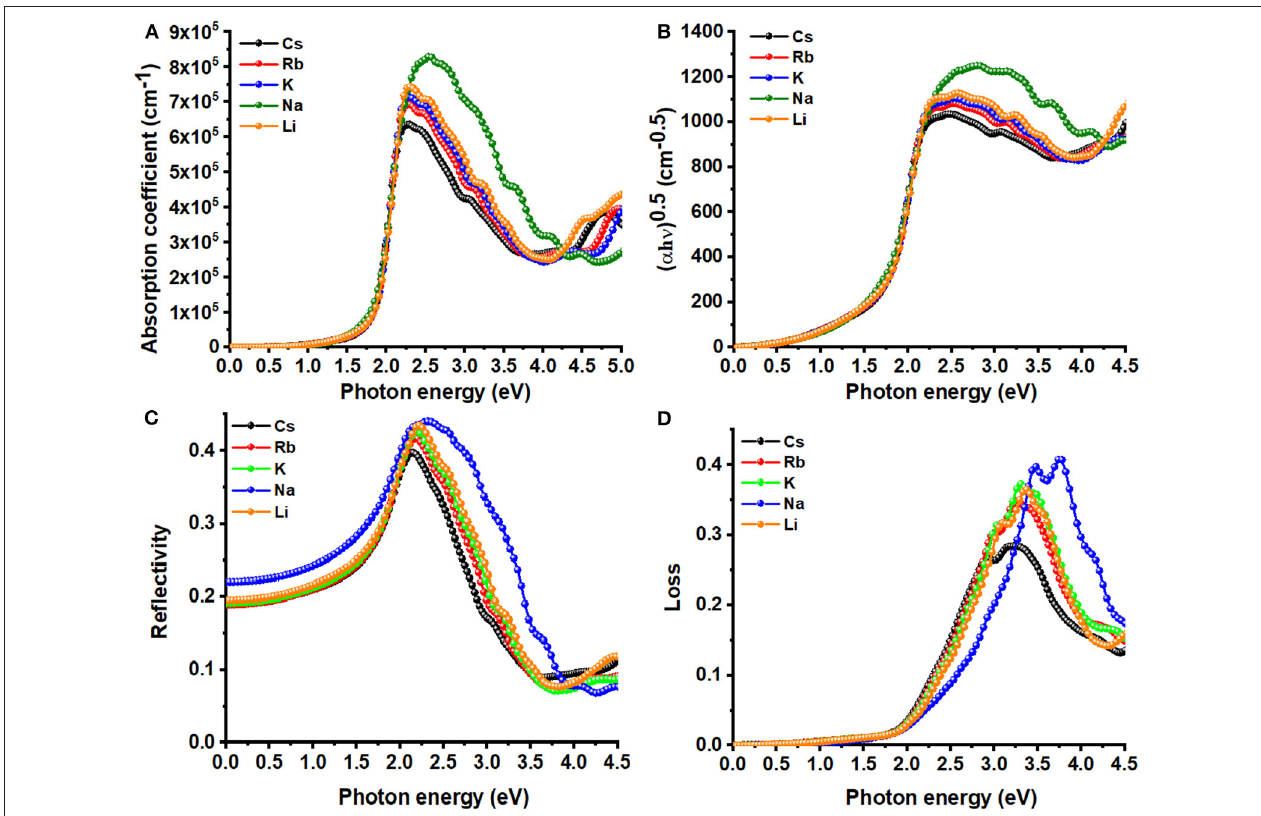
FIGURE 5 | Dependence of the (A) absorption coefficient, (C) reflectivity, (D) energy-loss function on the photon energy of A 2 AgRhCl 6 ( A Displayed in (B) is the Tauc plot for the corresponding systems. Primitive cells and k -mesh 18